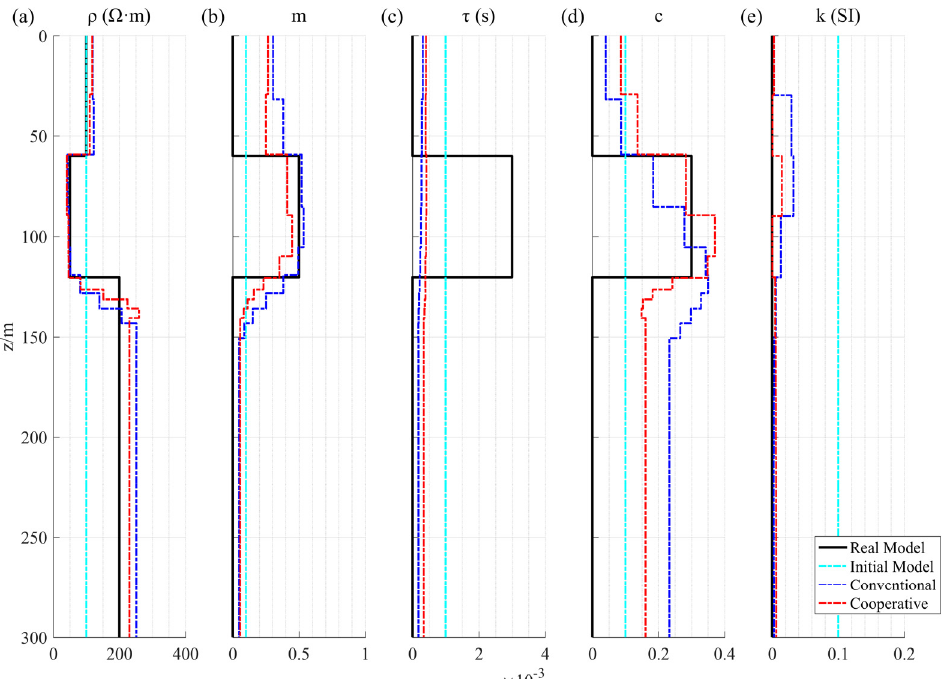
Figure 16. Results of the petrophysical parameters’ inversion at 350 m: ( a ) resistivity; ( b ) chargea- bility; ( c ) time constant; ( d ) frequency dependence; ( e ) permeability. ( c ) time constant; ( d ) frequency dependence; ( e )